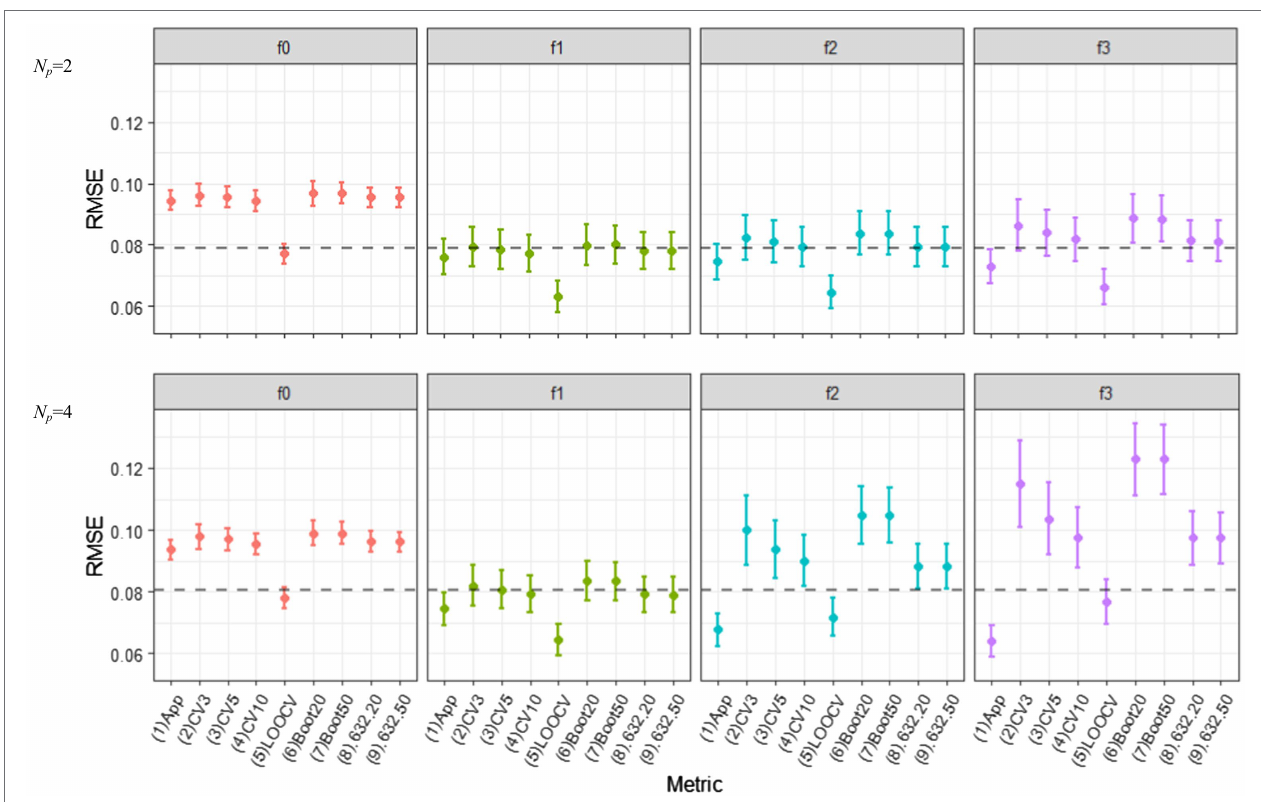
FIGURE 4 | Behavior of out-of-sample prediction error estimators based on various resampling methods, as the model complexity ( Np = 2 and 4) are varied different conditions of model mis-specifications (f0, f1, f2, and f3). The training sample size is N =